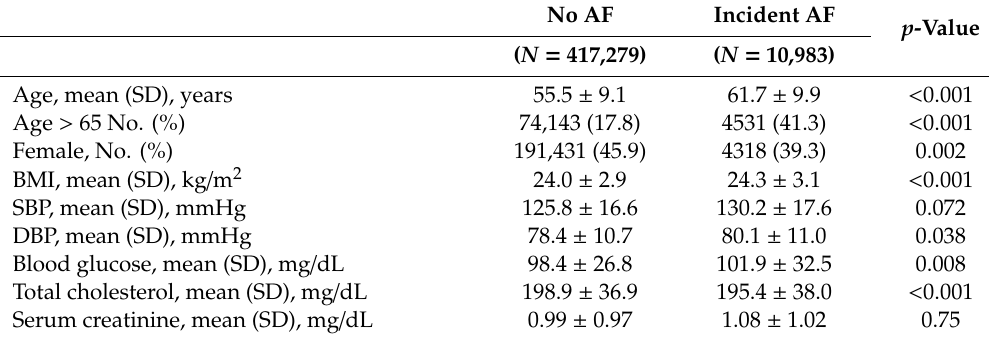
Table 1. Baseline